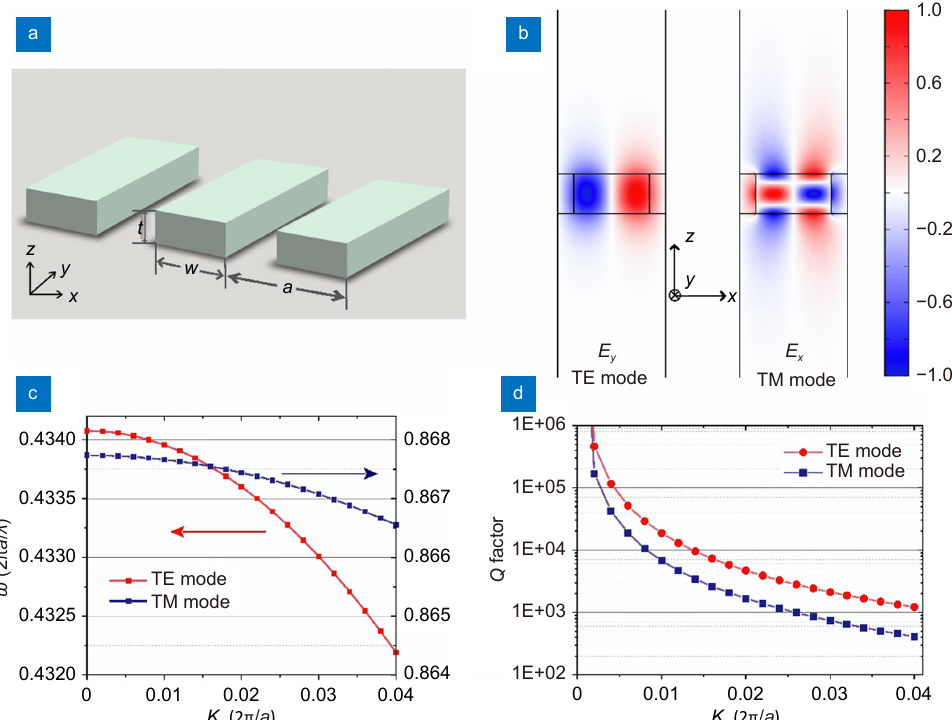
Fig. 1 | Photonic grating slab with a pair of BICs for enhancing SHG. ( a ) Photonic grating slab that contains TE-type and TM-type BICs. ( b ) Spatial distribution of the electric field of TE and TM modes in a unit cell at K x = 0, respectively. ( c ) Band structure of the target TE and TM modes of the photonic grating slab with thickness t = 0.37 · a , respectively. ( d ) K x dependent quality factor of the TE and TM modes shown in (c),